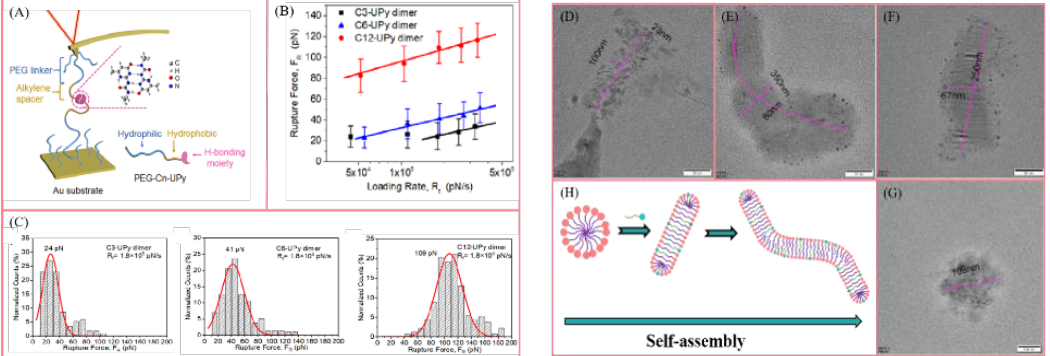
Figure 8. ( A – C ) The synergistic effect between hydrogen bonding and hydrophobic interaction was studied by Chen and coworkers [79]. ( D – H ) Through Cryo-TEM, our group revealed the solubili- zation mechanism of surfactant and determined the solubilization site